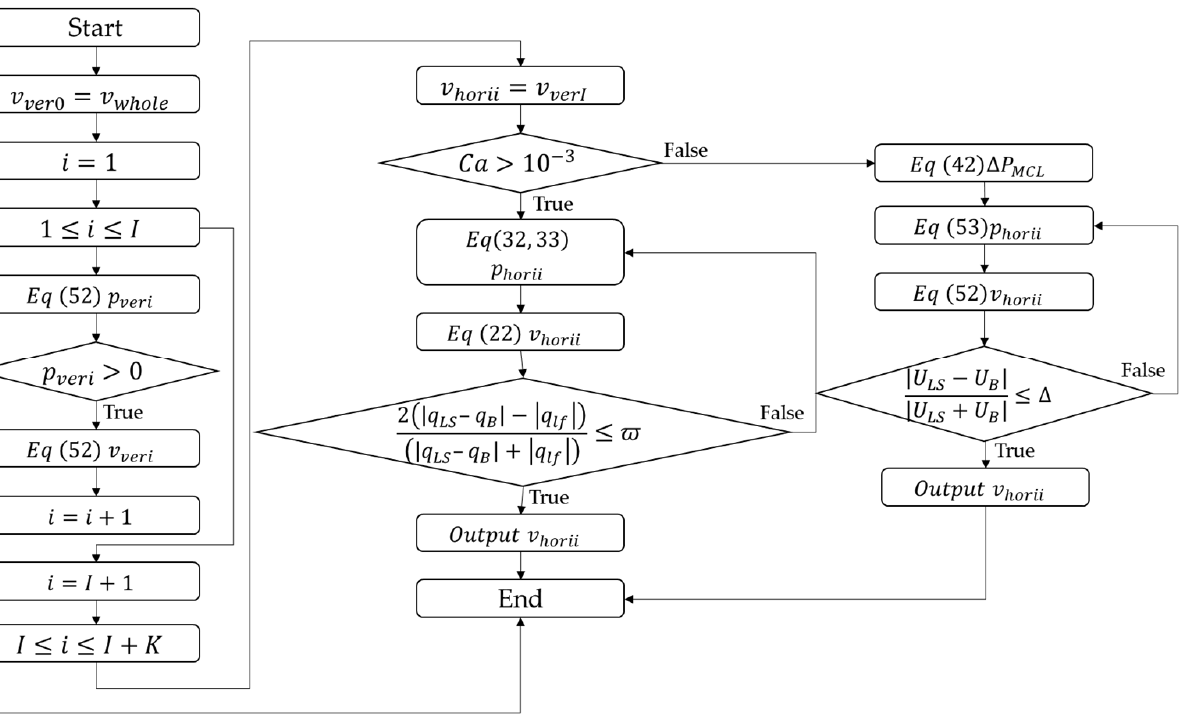
Figure 8. Flowchart of velocity calculation of the siphon with a long horizontal section.